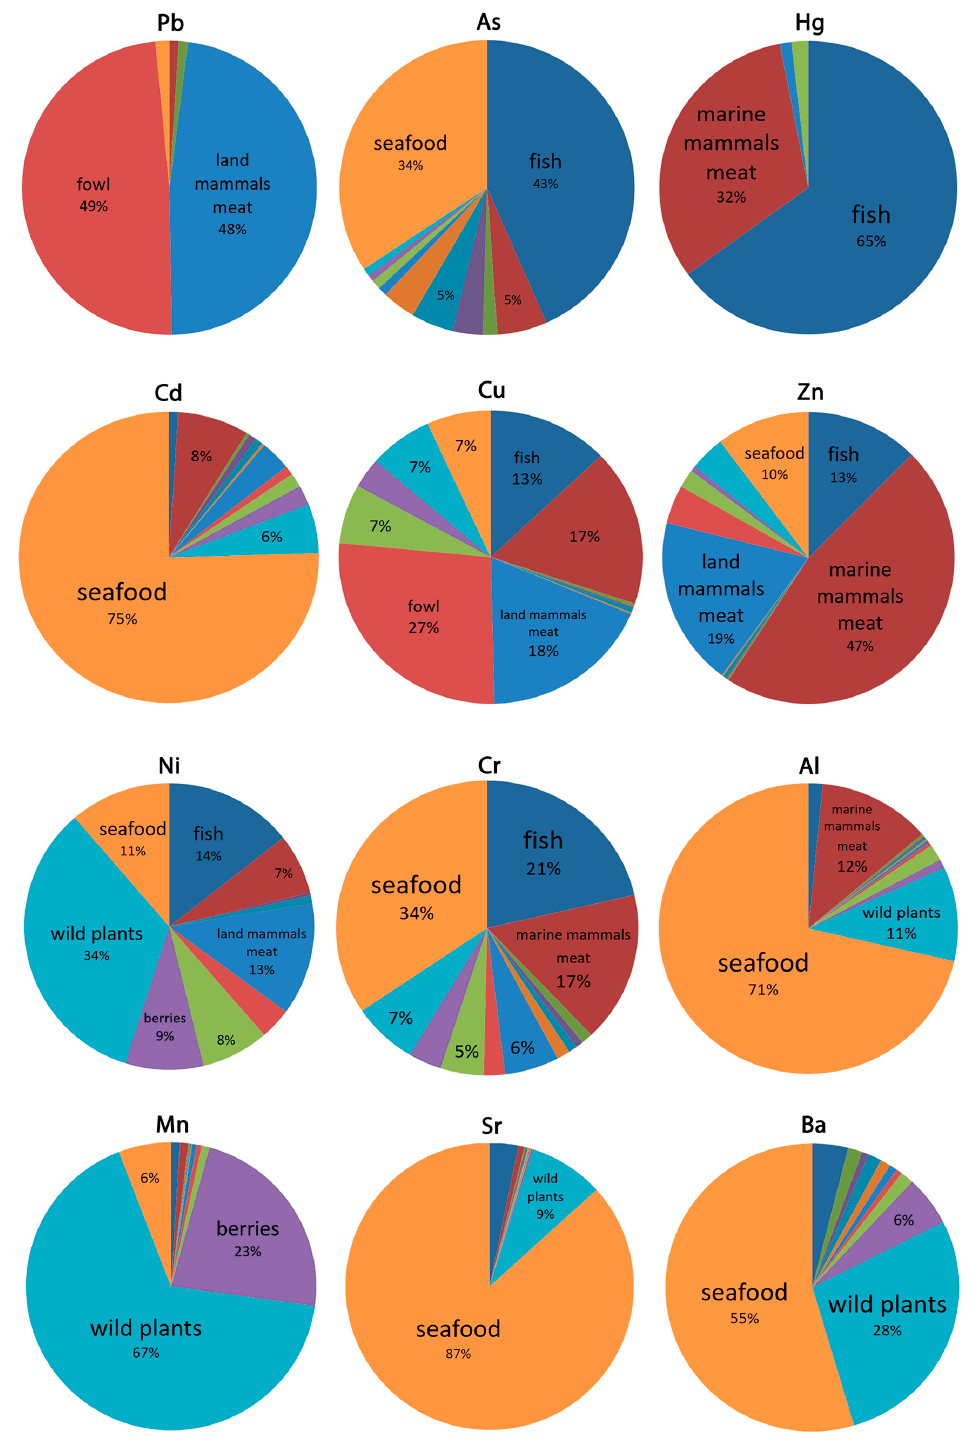
Figure 3. Structure of the estimated daily intakes (EDIs) of metals by local food consumption, %.